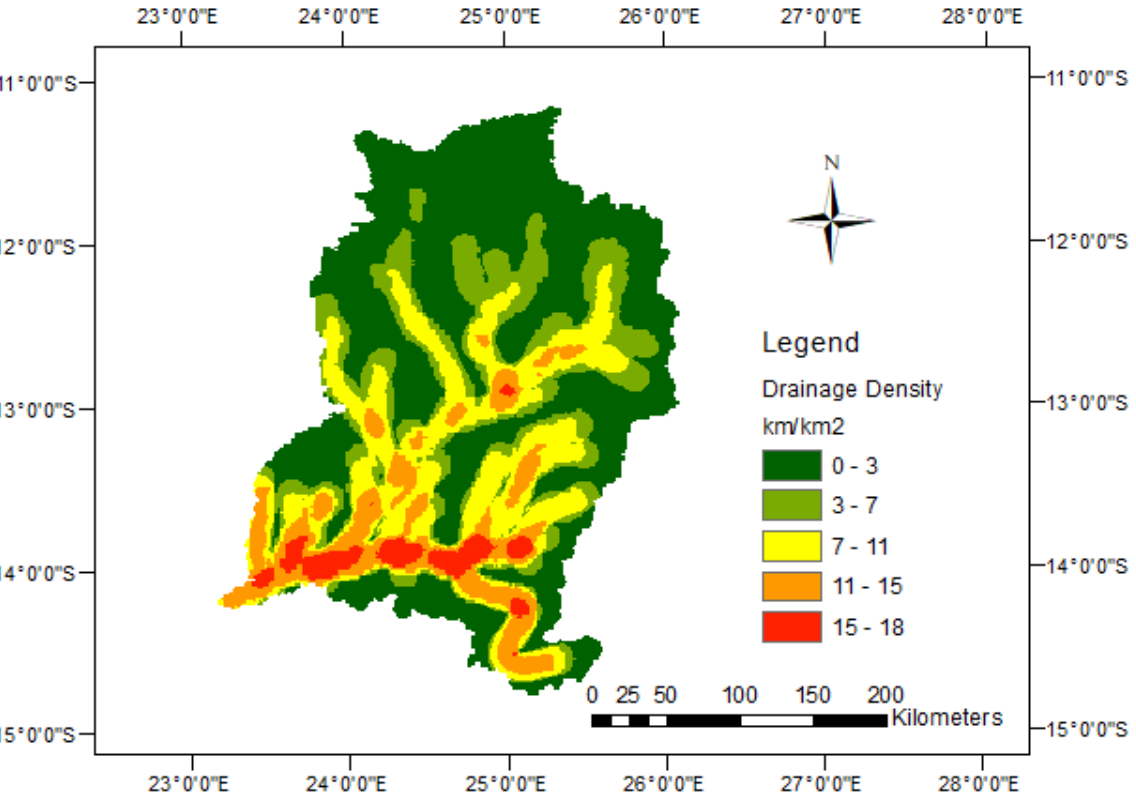
Figure 4. The drainage density of Kabompo catchment.